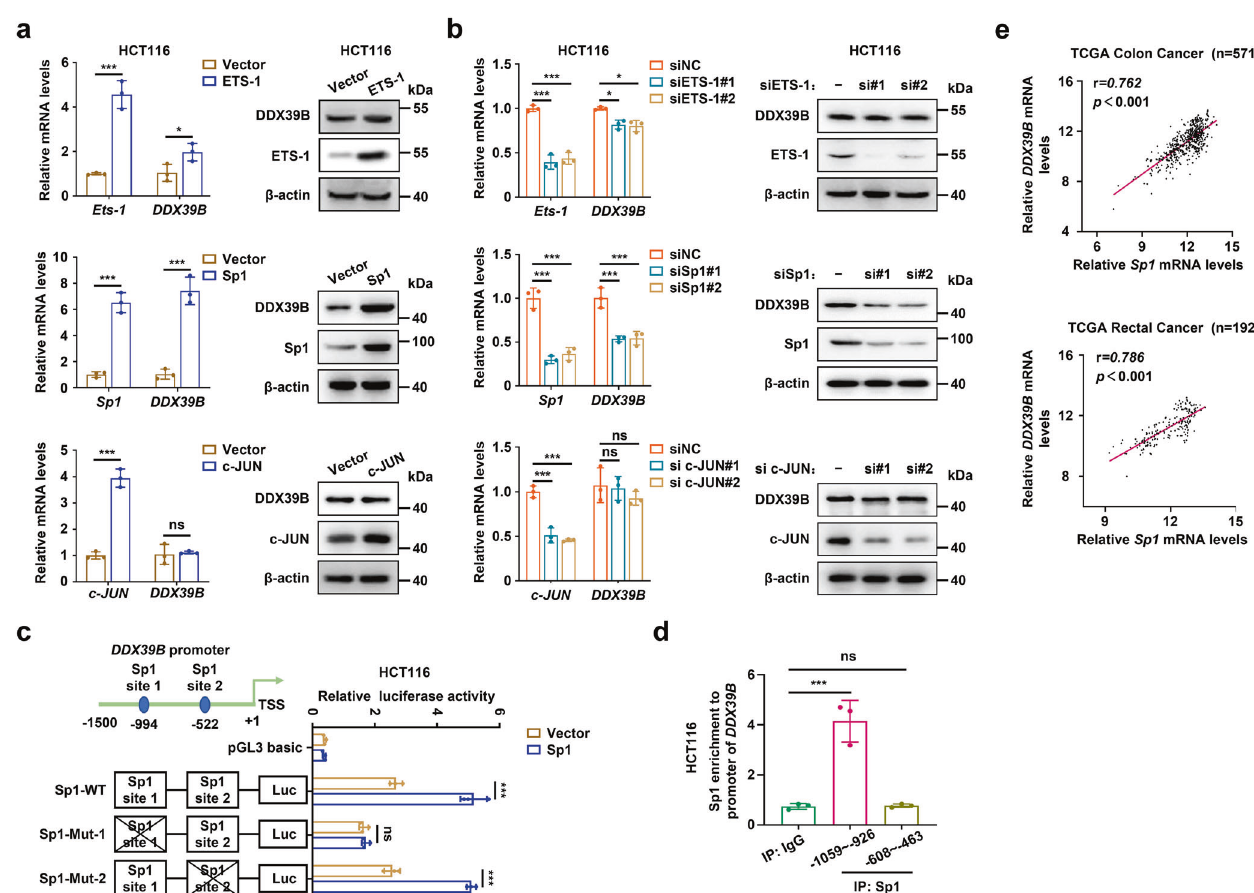
Fig. 2 Sp1 activates DDX39B transcription in CRC cells. a HCT116 cells were transiently transfected with the plasmids of ETS-1, Sp1, or c-JUN, respectively. The mRNA and protein levels of DDX39B were measured by qPCR and western blotting. b HCT116 cells were transiently transfected with siRNAs targeting ETS-1, Sp1, or c-JUN, respectively. The mRNA and protein expressions of DDX39B were determined by qRT- PCR and western blotting. c The relative luciferase activity was detected in HCT116 cells transfected with the indicated DDX39B promoter in the presence or absence of Sp1. d DNA fragments from HCT116 cells were immunoprecipitated with the Sp1-speci fi c antibody and analyzed by qPCR using the indicated primers. e The correlations of transcript levels between DDX39B and Sp1 in human colon and rectal adenocarcinoma tissues were analyzed through an online tool (https://xenabrowser.net/). Data are presented as mean ± SD. The p values were obtained by two-tailed unpaired t test ( a ) or one-way ANOVA ( b – d ). * p < 0.05, *** p < 0.001, ns not signi fi